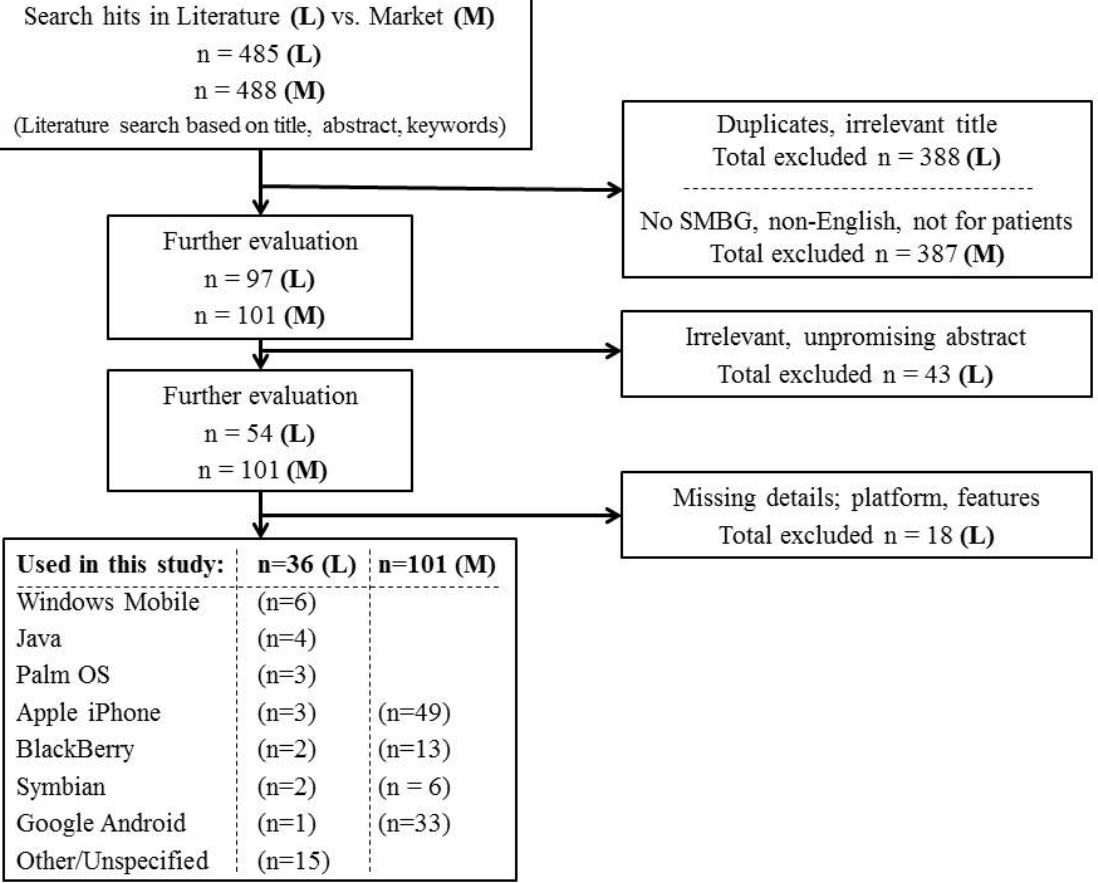
Figure 1. Selection process for online journal databases and online markets (SMBG = self-monitoring of blood